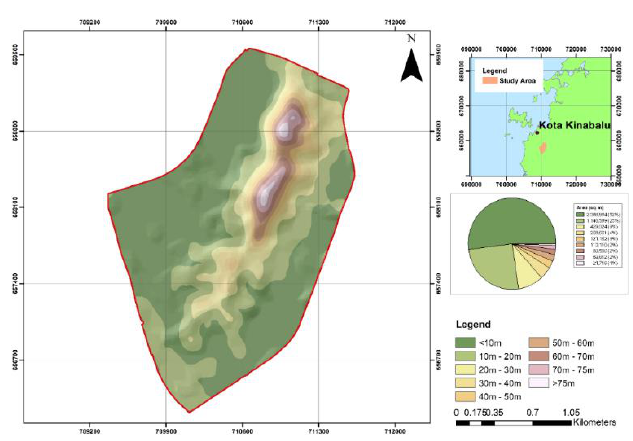
Figure 2: Location of the study area